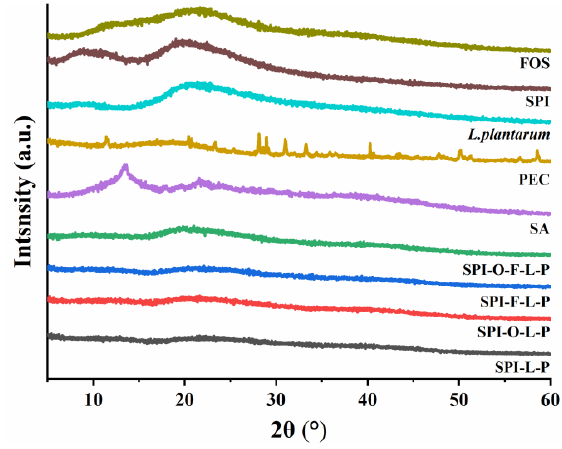
Figure 5. XRD pattern of different samples.